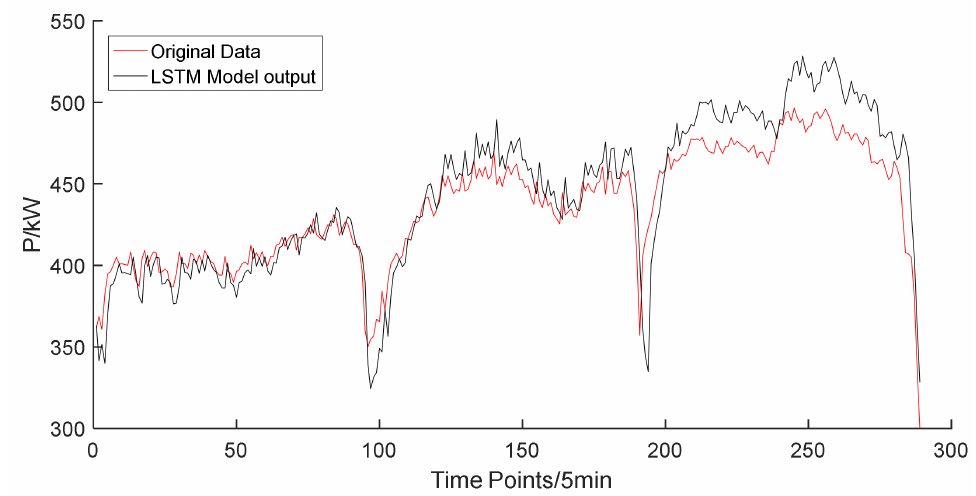
Figure 2. Accumulate error of the forecasting